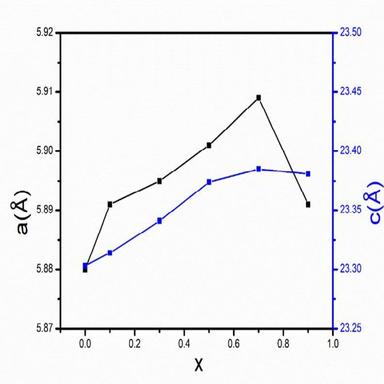
Variation of lattice parameters (ܽ and ܿ) with substitution (x)